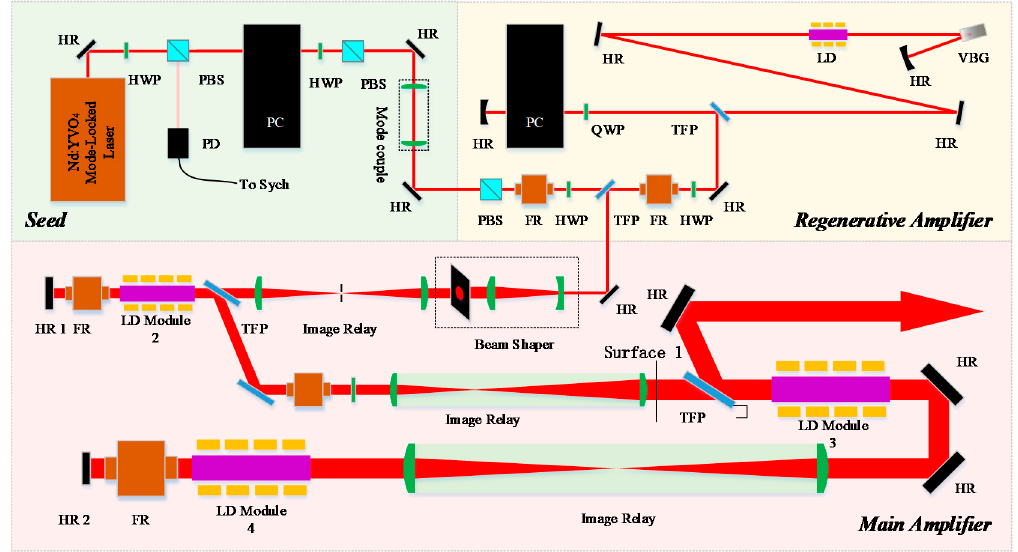
Figure 1. Schematic of the laser system. HR: high reflector; HWP: half-wave plate; PBS: polarization beam splitter; PD: photo diode; PC: Pockels cell; FR: Faraday rotator; TFP: thin-film plate; QWP: quarter-wave plate; LD: laser diode; VBG: volume Bragg grating.